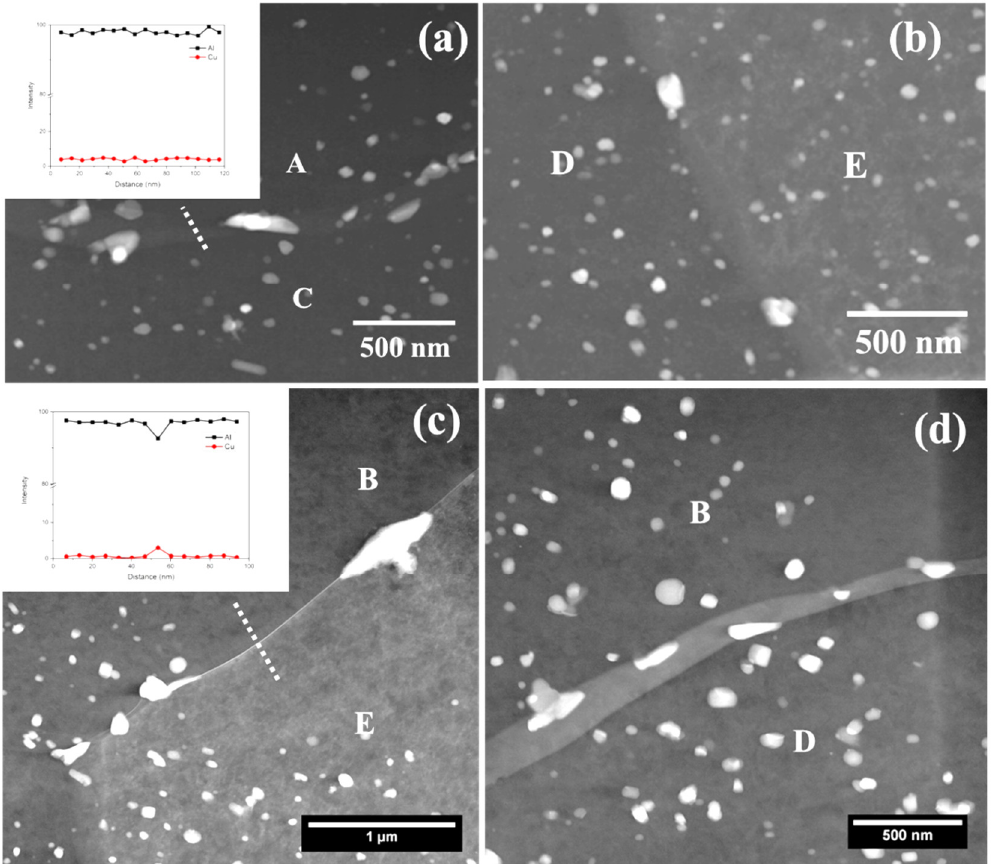
Figure 5. ( a ) HAADF micrograph of boundary A‐C of Figure 4 with elemental profile inset; ( b ) HAADF micrograph of boundary D‐E of Figure 4; ( c ) HAADF micrograph of boundary B‐E of Figure 4 with elemental profile inset; ( d ) HAADF micrograph of boundary B‐D of Figure 4.